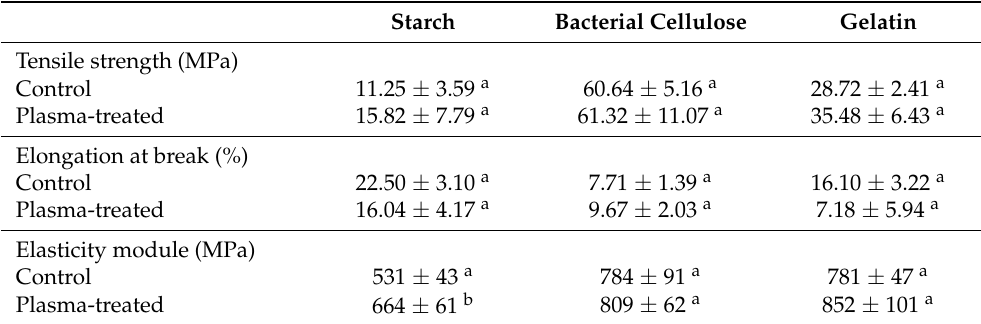
Table 8. Mechanical properties of the starch, bacterial cellulose, and gelatin films treated for 20 min with dielectric barrier discharge plasma at an optimal excitation frequency (50 Hz for the starch film and 900 Hz for the bacterial cellulose and gelatin films) without Mylar™ support. For each property, values followed by at least one common letter are not different from each other ( p > 0.05).